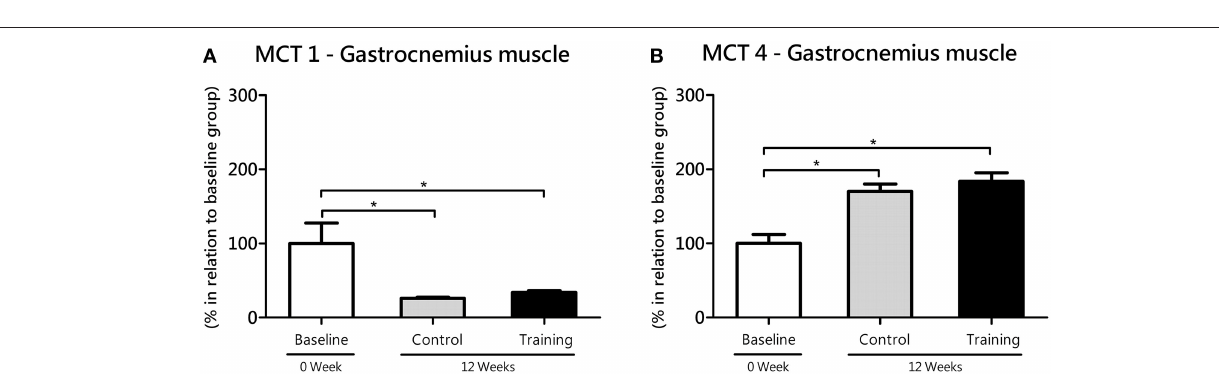
FIGURE 5 | mRNA level of monocarboxylate transporters (MCT) 1 (A) and 4 (B) in the white gastrocnemius (glycolytic) muscle for the control and training exercise groups. The data (mean ± SEM) are relative (%) to baseline group, which has been set at 100%. Newman-Keuls post hoc test was used to locate group’s difference. N = 9 –10 rats per group. Sig. diff. * P < 0.05